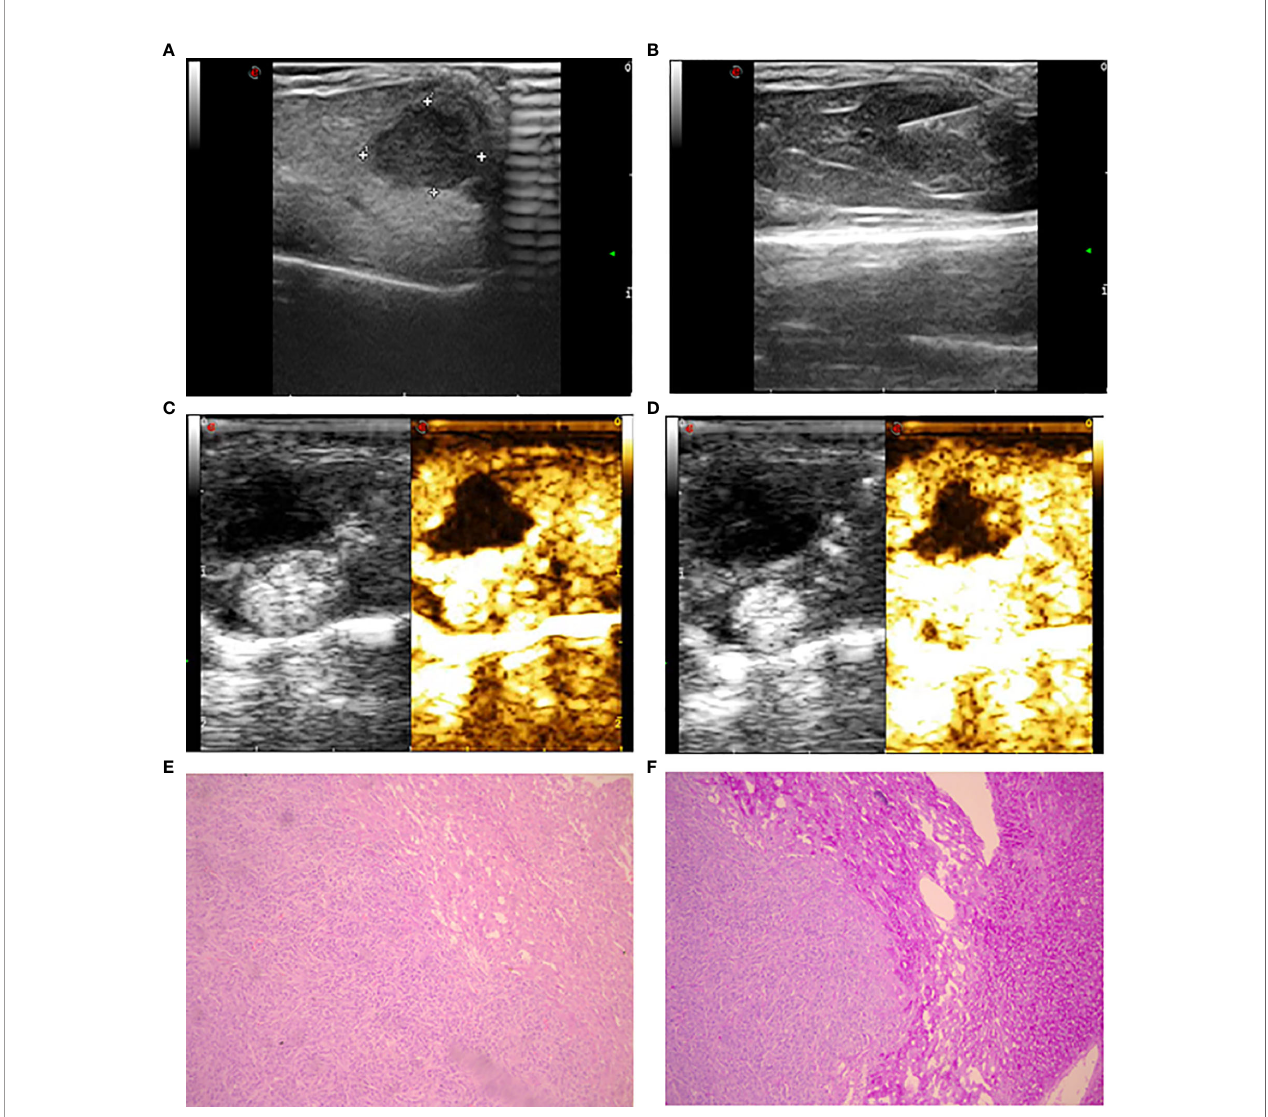
FIGURE 1 | Ultrasonic image and histopathology of the implanted tumor. (A) Gray ultrasound showed hypoechoic metastases in the liver parenchyma with clear boundaries. (B) Ultrasound showed laser fi ber into the center of the tumor. (C) The 5-second image of contrast-enhanced ultrasound in liver metastases. (D) The 25- second image of contrast-enhanced ultrasound in liver metastases. (E) The morphology of intestinal adenocarcinoma cells was uniform with large and deep stained nuclei (HE staining). (F) Compared to intratumoral tissue, there was increased staining in liver tissue with clear edges (periodic acid-Schiff